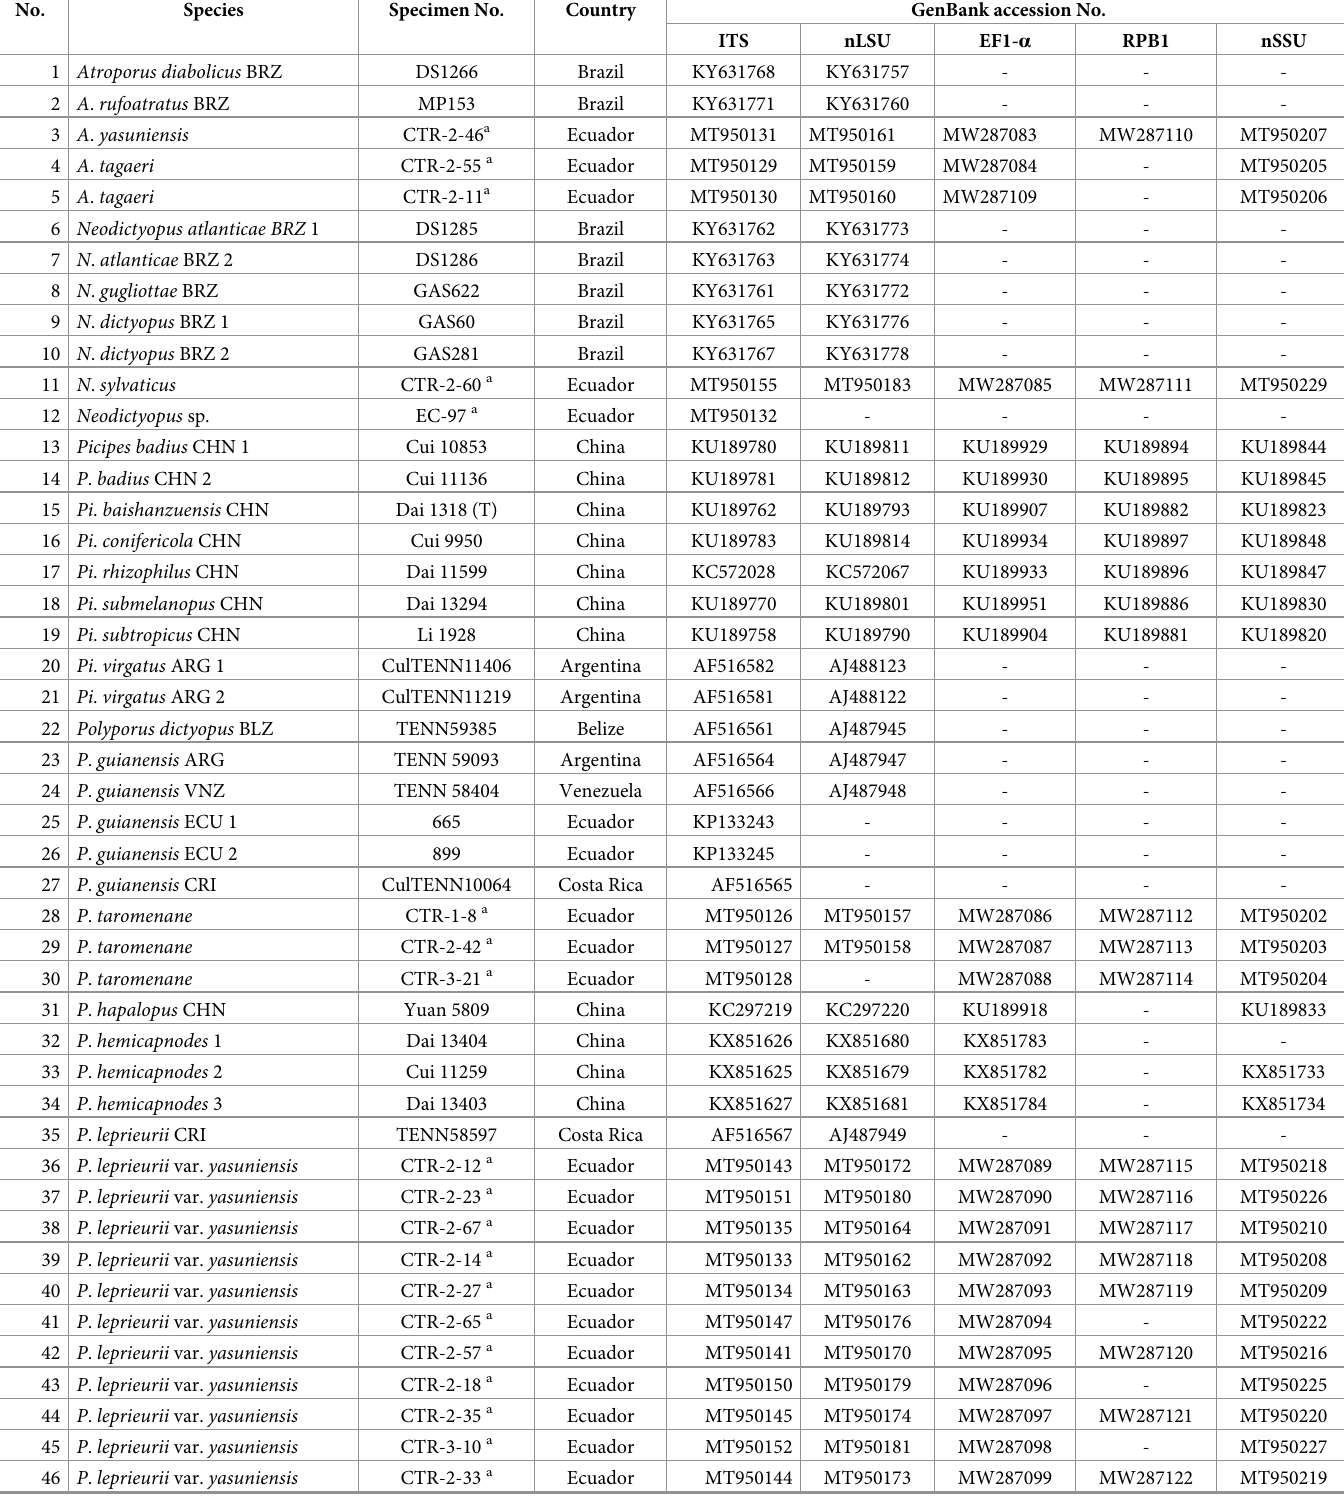
Table 1. Species list of Polyporus and related genera used in this study and GenBank entries.